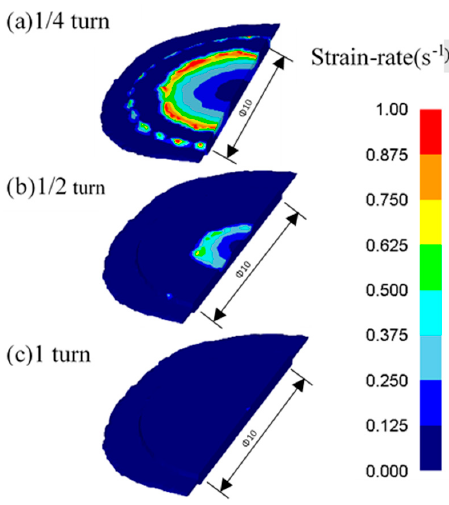
Figure 5. Distribution of strain-rate on the half-disc surfaces and along the disc longitudinal sections for samples with ( a ) 1/4 turn; ( b ) 1/2 turn; and ( c ) 1 turn.